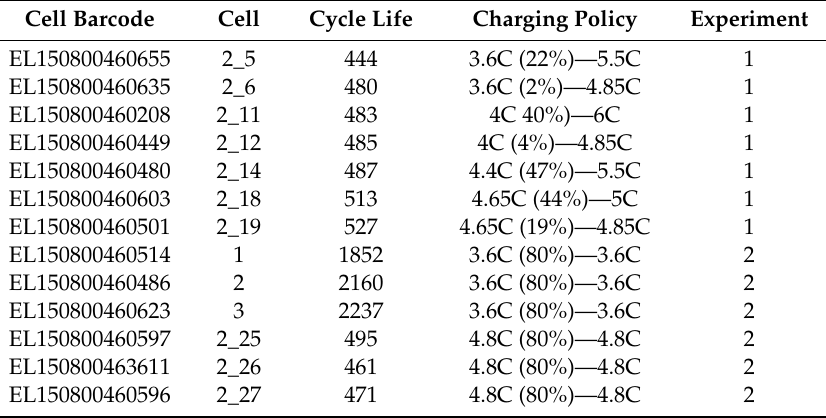
Table 1. Summary of the thirteen